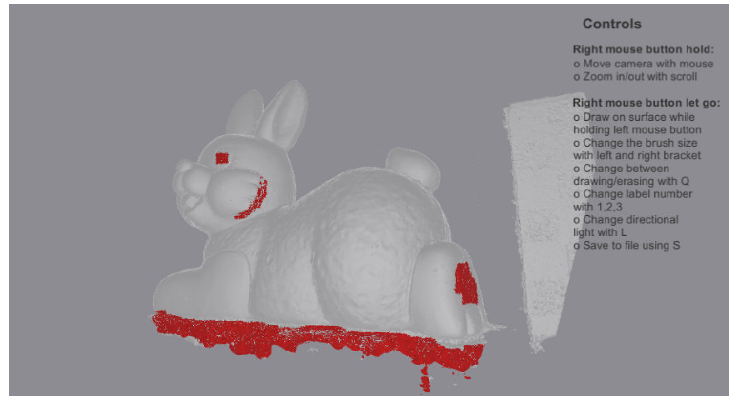
Figure 10. View from the annotation tool used for creating the roughness versus noise ground truth for each of the meshes. The vertices painted red are set as reconstruction noise.